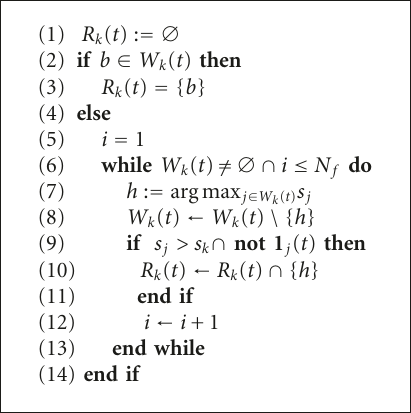
Algorithm 1: Routing decision